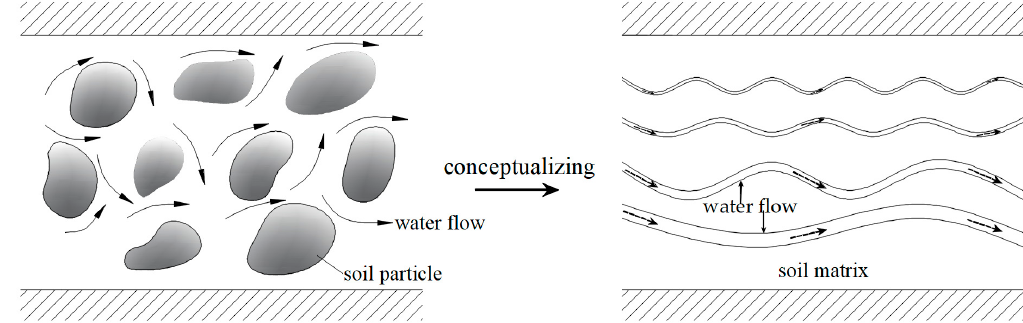
Figure 1. Schematic of capillary bundle model of frozen soil.